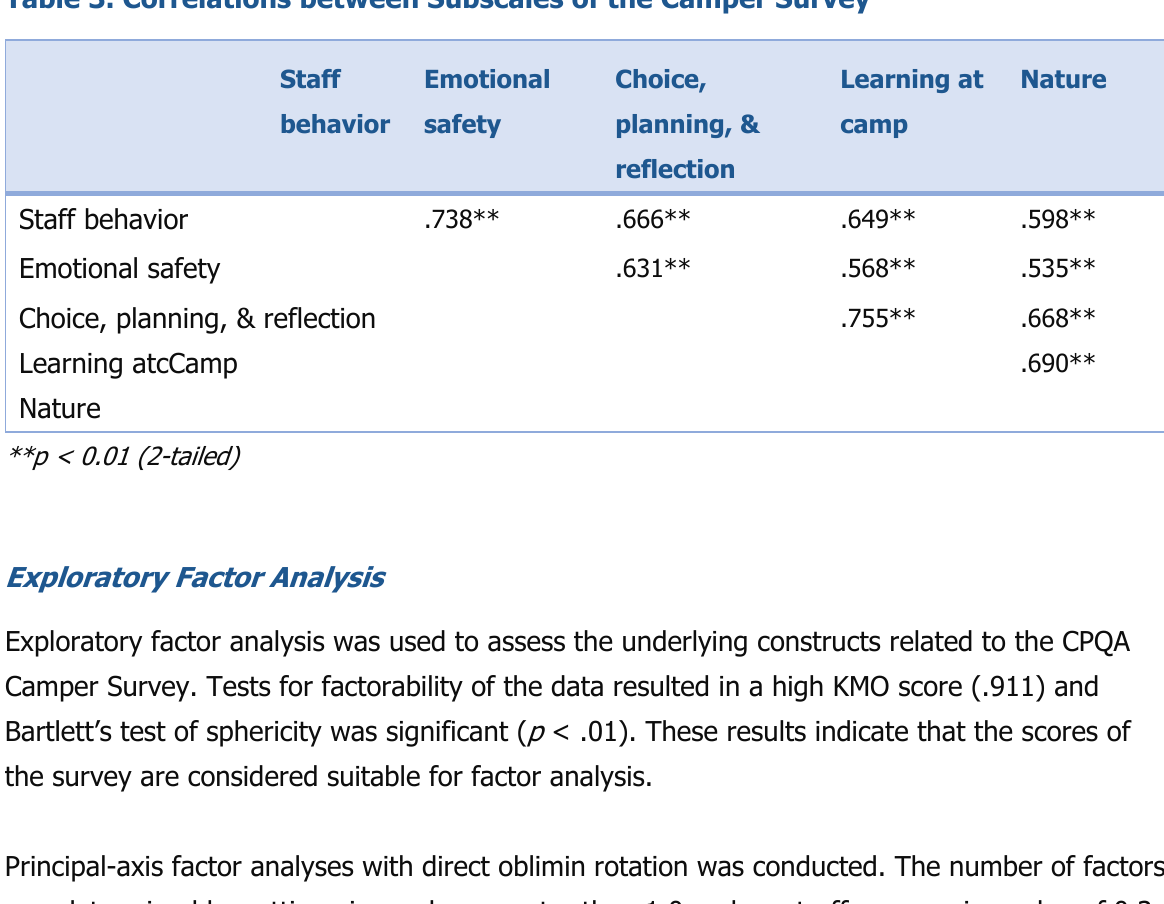
Table 3. Correlations between Subscales of the Camper